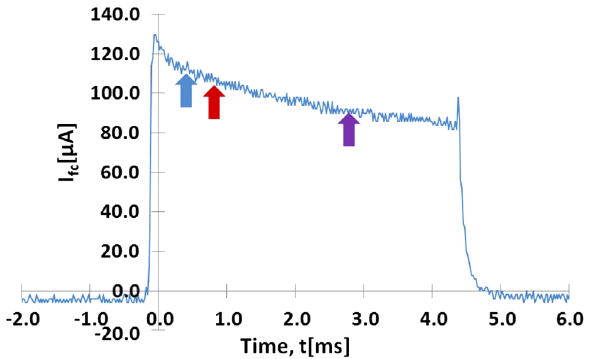
FIG. 13. He 1 þ ion beam pulse with a duration of 5 ms captured by the Faraday cup (chopped at 1 ms).